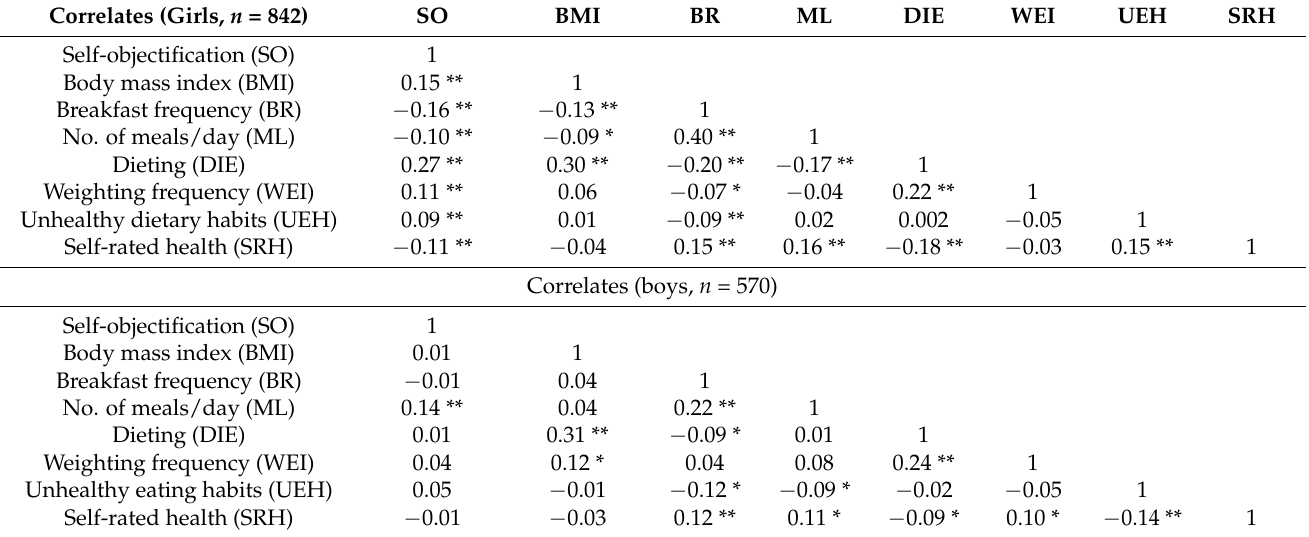
Table 3. Associations between self-objectification, body mass index, self-rated health, and eating- related attitudes and behaviors in adolescent boys and girls ( n = 1412).